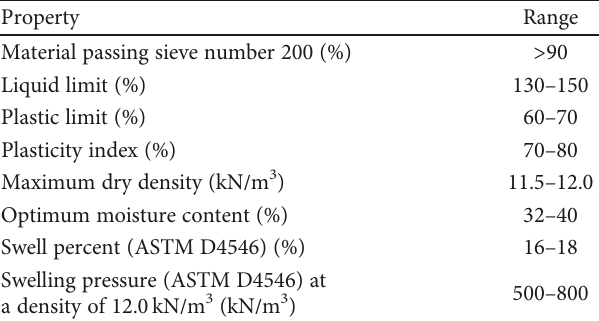
Table 1: Physical properties of Al-Qatif clay.